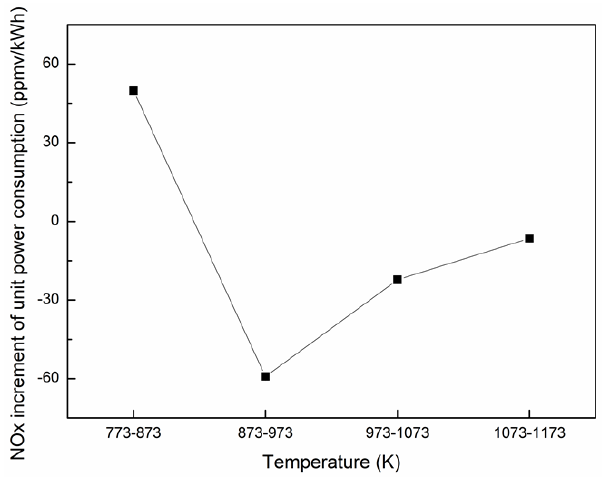
Figure 9. NO X increment of unit power consumption in different temperature phases.